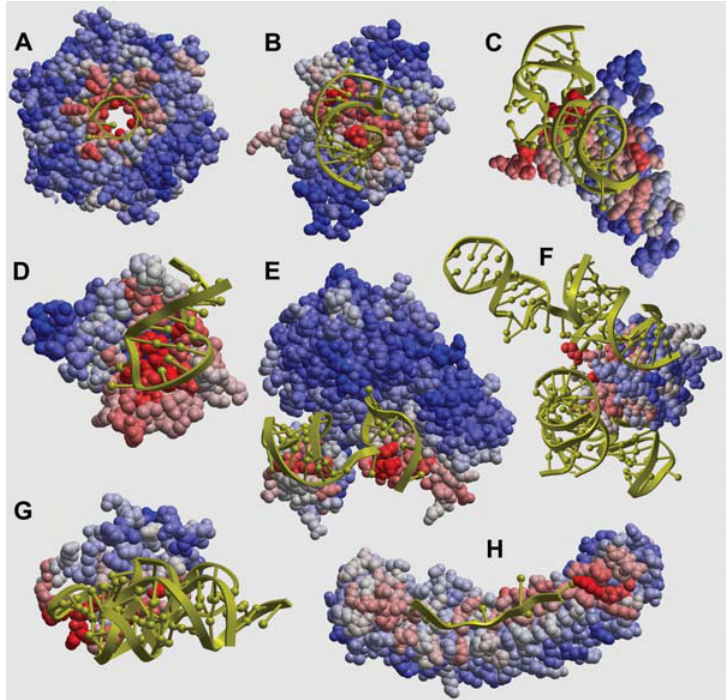
Figure 2 Examples of RNA-binding site predictions on protein surfaces. Unbound protein residues predicted to be involved in RNA-binding according to the OPRA method are colored in red. For comparison purposes, the position of the RNA in the reference complex structure is shown in yellow ribbon. (A) Hfq pleiotropic translational regulator (unbound PDB 1KQ1; complex PDB 1KQ2). (B) PP7 coat dimer protein (unbound PDB 2QUD; complex PDB 2QUX). (C) SmpB tmRNA- binding protein from Aquifex aeolicus (unbound PDB 1K8H; complex PDB 1P6V). (D) Aspergillus ribotoxin (unbound PDB 1AQZ;